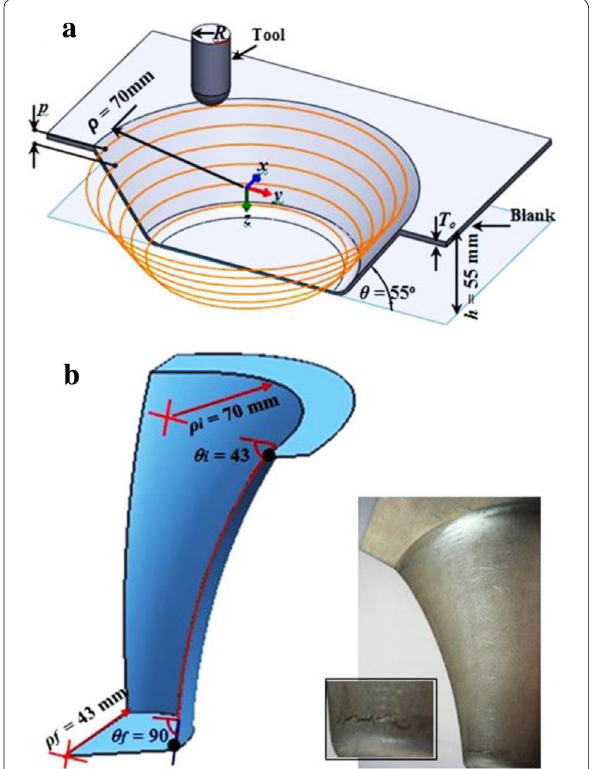
Figure 1 The terminology and test geometries: a Fixed angle frustum of cone, and b Varying wall angle frustum of